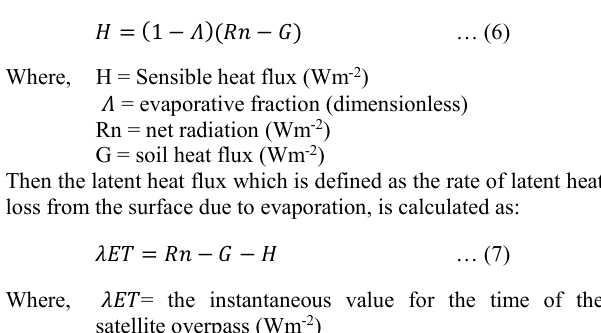
Detailed procedure for calculation of these parameters